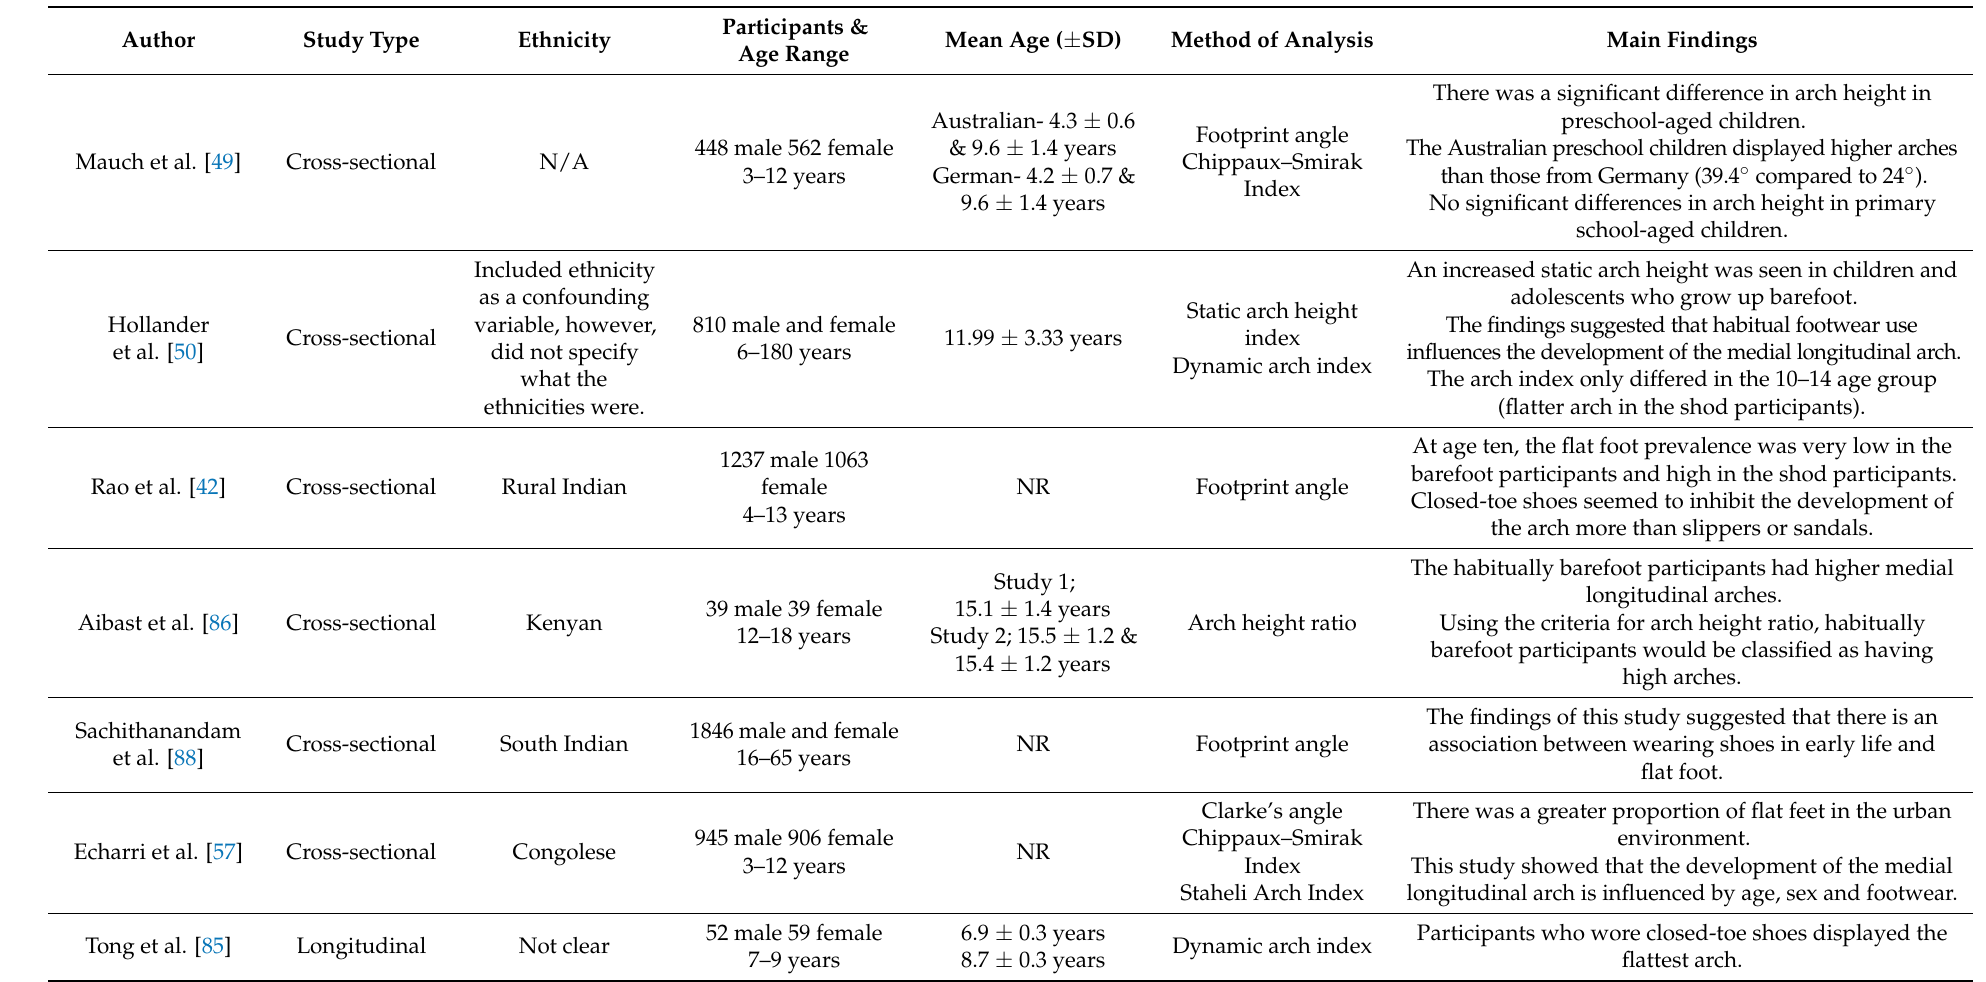
Table 5. A summary of the studies examined relating to footwear habits and medial longitudinal arch